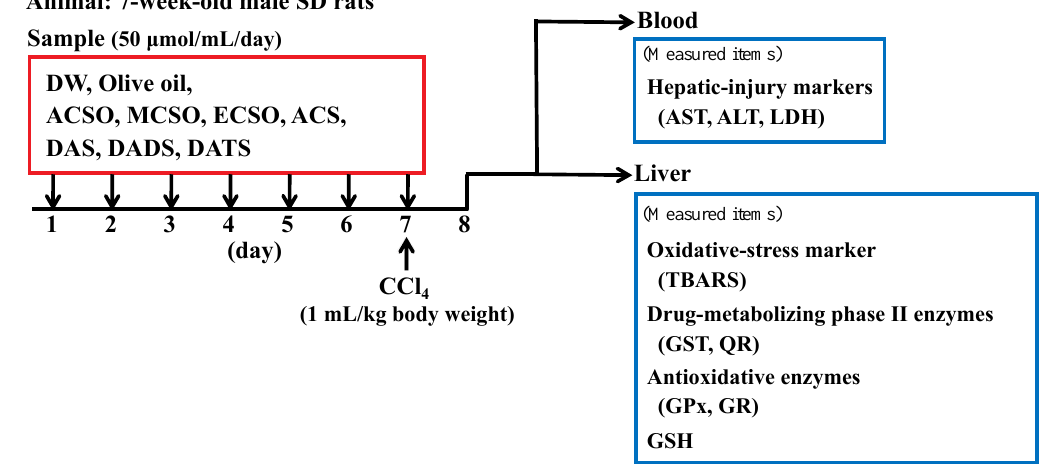
Figure 2. Animal experimental design for evaluation of the suppressive effects of S -allyl- L -cysteine sulfoxide (ACSO) and its related compounds on hepatic injury induced by CCl 4 .